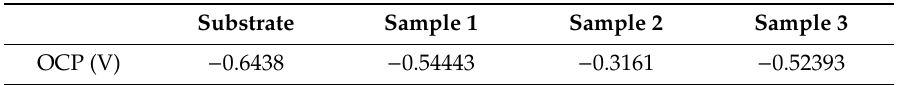
Table3. Theopencircuitpotential(OCP)ofthesubstrateandcermetcoatingsimmersedinNaClsolution.